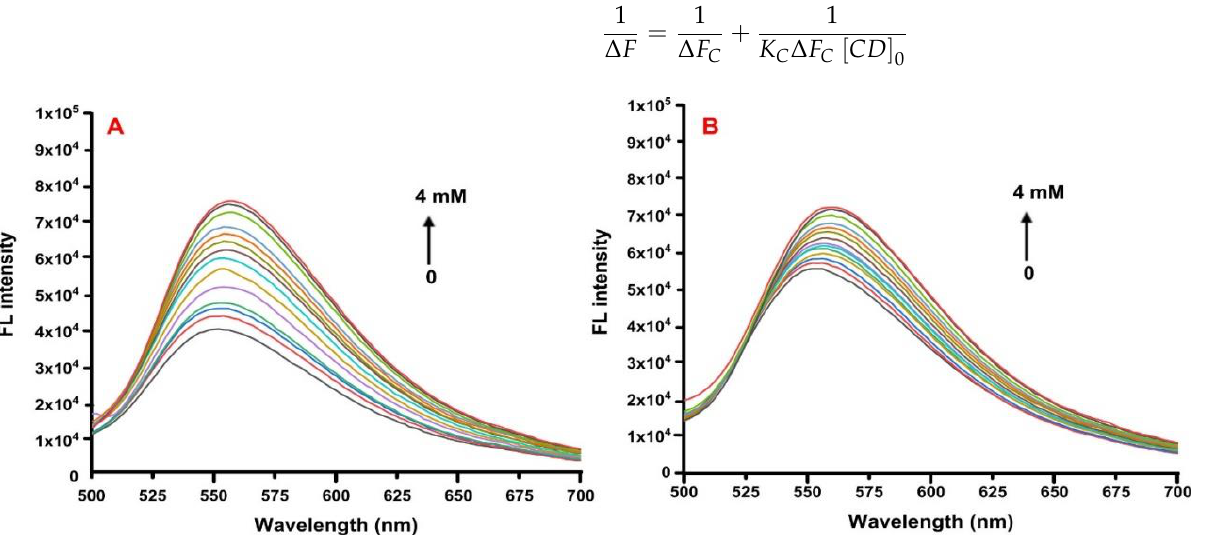
Figure 9. Fluorescence spectra of QUE ( 25 μM) at pH 7.4 (DMSO/PBS buffer, 10 mM) after titrating with various concentrations of CDs (0, 0.1, 0.2, 0.3, 0.4, 0.5, 0.6, 0.7, 0.8, 0.9, 1.0, 2.0, 3.0 and 4.0) ( A ) 2HP- β -CD and ( B ) 2,6-Me- β -CD. The straight line of the double reciprocal plot confirms the 1:1 stoichiometry of QUE with CDs and the binding constants were calculated equal to 520 ± 32 M − 1 and 771 ± 51 M − 1 for 2HP- β -CD and 2,6Me- β -CD, respectively, indicating a moderate affinity between the two molecules (Figure